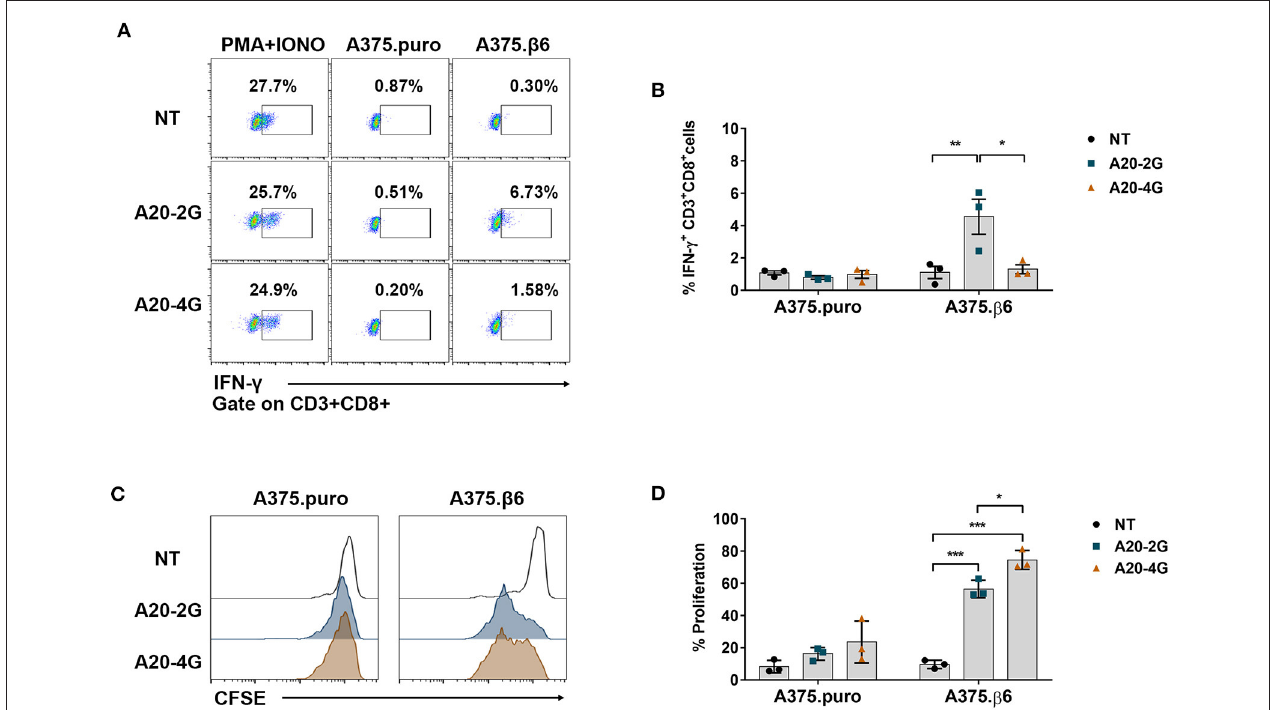
FIGURE 6 | Production of interferon- γ (IFN- γ ) and cell proliferation non-transduced (NT) T cells, A20-2G CAR T cells, and A20-4G CAR T cells after co-culture with integrin α v β 6-expressing target cells. (A) IFN- γ production was examined by intracellular cytokine staining and flow cytometry analysis in NT T cells, A20-2G CAR T cells, and A20-4G CAR T cells after co-culturing with integrin α v β 6-negative A375.puro or integrin α v β 6-positive A375. β 6 cells. (B) IFN- γ expression from three individual healthy donors. Data are presented as mean ± standard error of the mean (SEM). (C) Proliferation of NT cells, A20-2G CAR T cells, and A20-4G CAR T